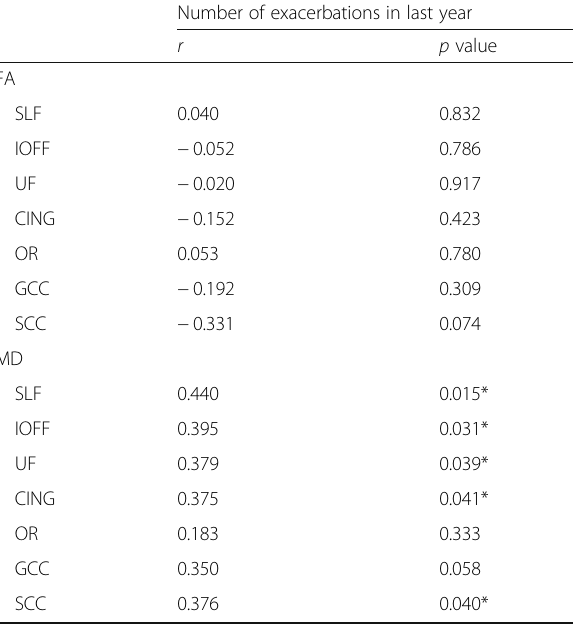
Table 3 The correlation between smoking index and DTI metrics